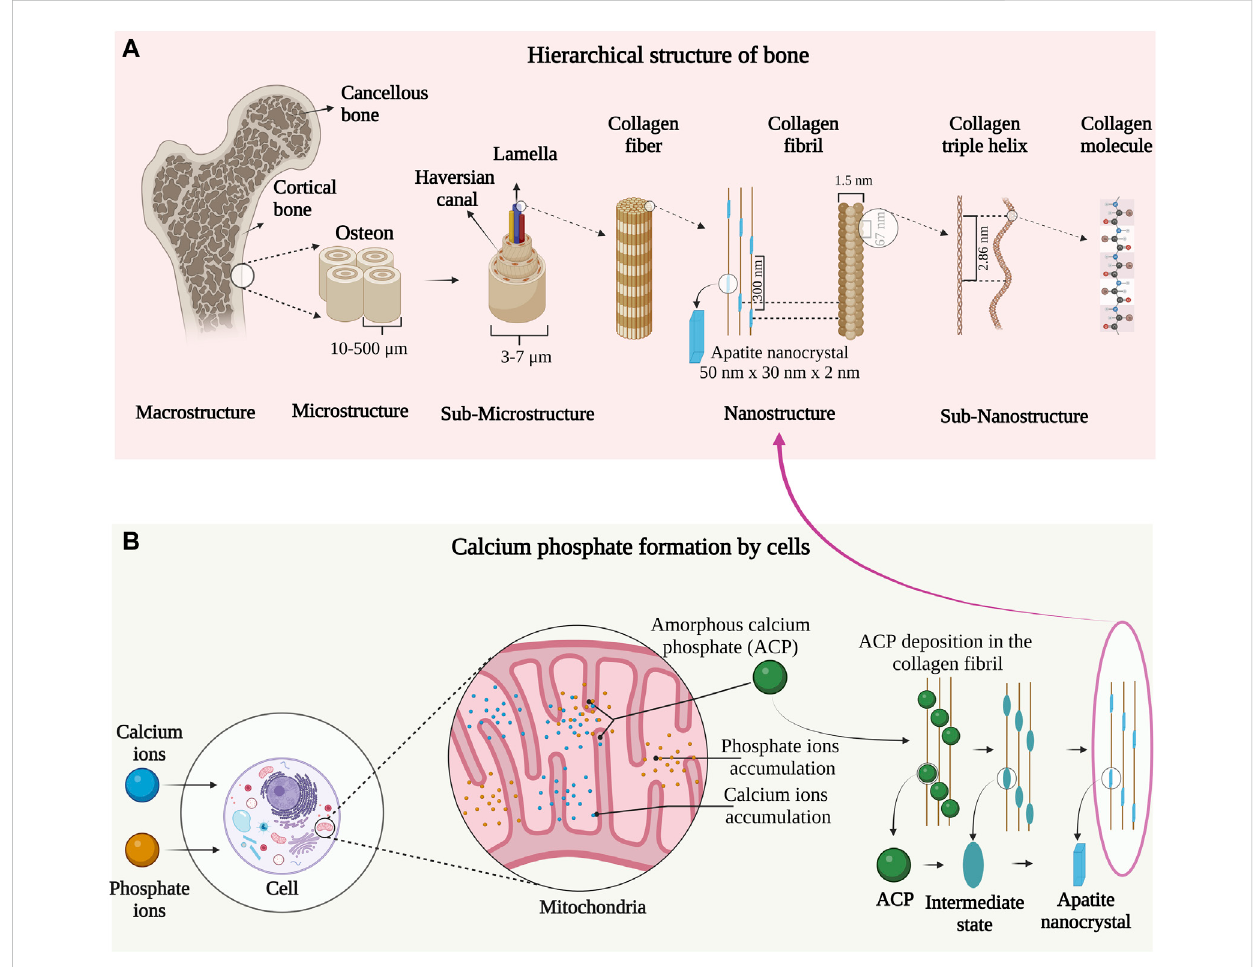
FIGURE 1 (A) Hierarchical organization of bone from macro to the nanoscale. Image inspired by the previous publication of (Rho et al., 1998). (B) Mitochondrial-dependent cellular mechanism of apatite nanocrystal formation. The image is inspired by the fi fth jubilee lecture on mitochondria and calcium ion transport (Lehninger,